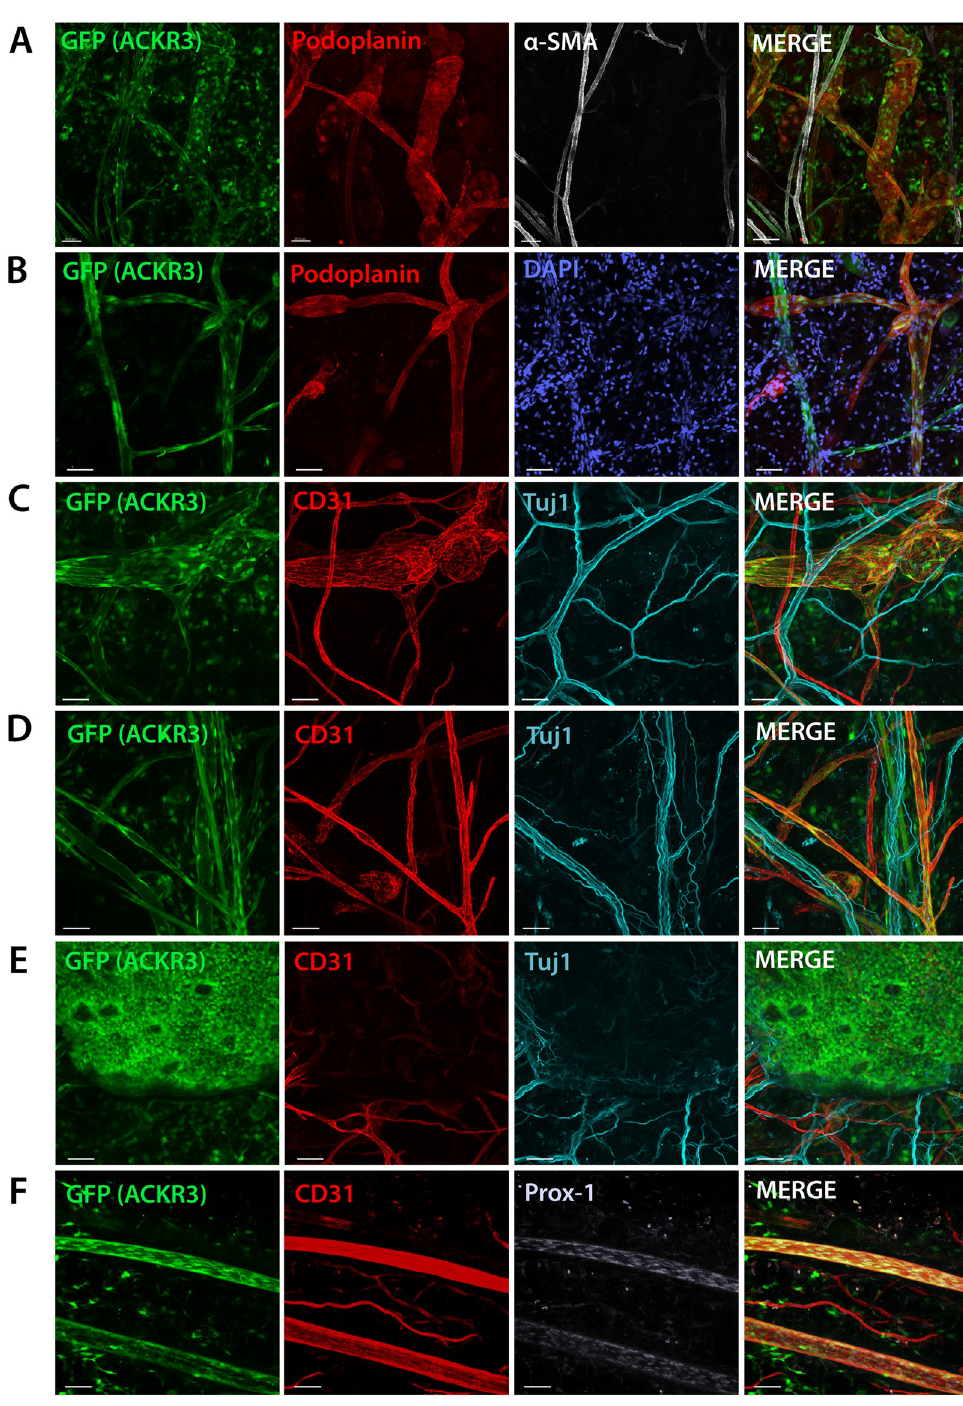
Fig 2. Analysis of GFP expression in the ear skin and flank collector of adult ACKR3 GFP/+ reporter mice. (A-E) Whole mounts were prepared from the ear skin of ACKR3 GFP/+ reporter mice. GFP was expressed by lymphatic vessels, blood vessels, various stromal cells and keratinocytes, in association with nerves, as evidenced by co-staining with (A) the lymphatic marker Podoplanin and alpha smooth muscle actin ( α SMA), (B) Podoplanin and DAPI, (C-E ) the panendothelial marker CD31 + and the neuronal marker TUJ1. (F) Whole mount analysis performed on preparations of the flank collector confirmed GFP expression in large CD31 + PROX-1 + lymphatic collectors. Scale bar: 50 μ m Representative images of four separate experiments with n = 4